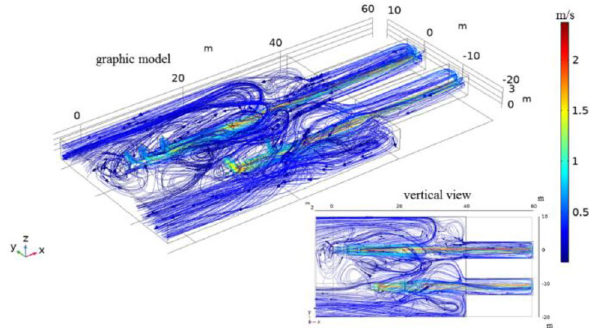
Figure 4. 26 Flow line diagram of the double tape wind flow field.